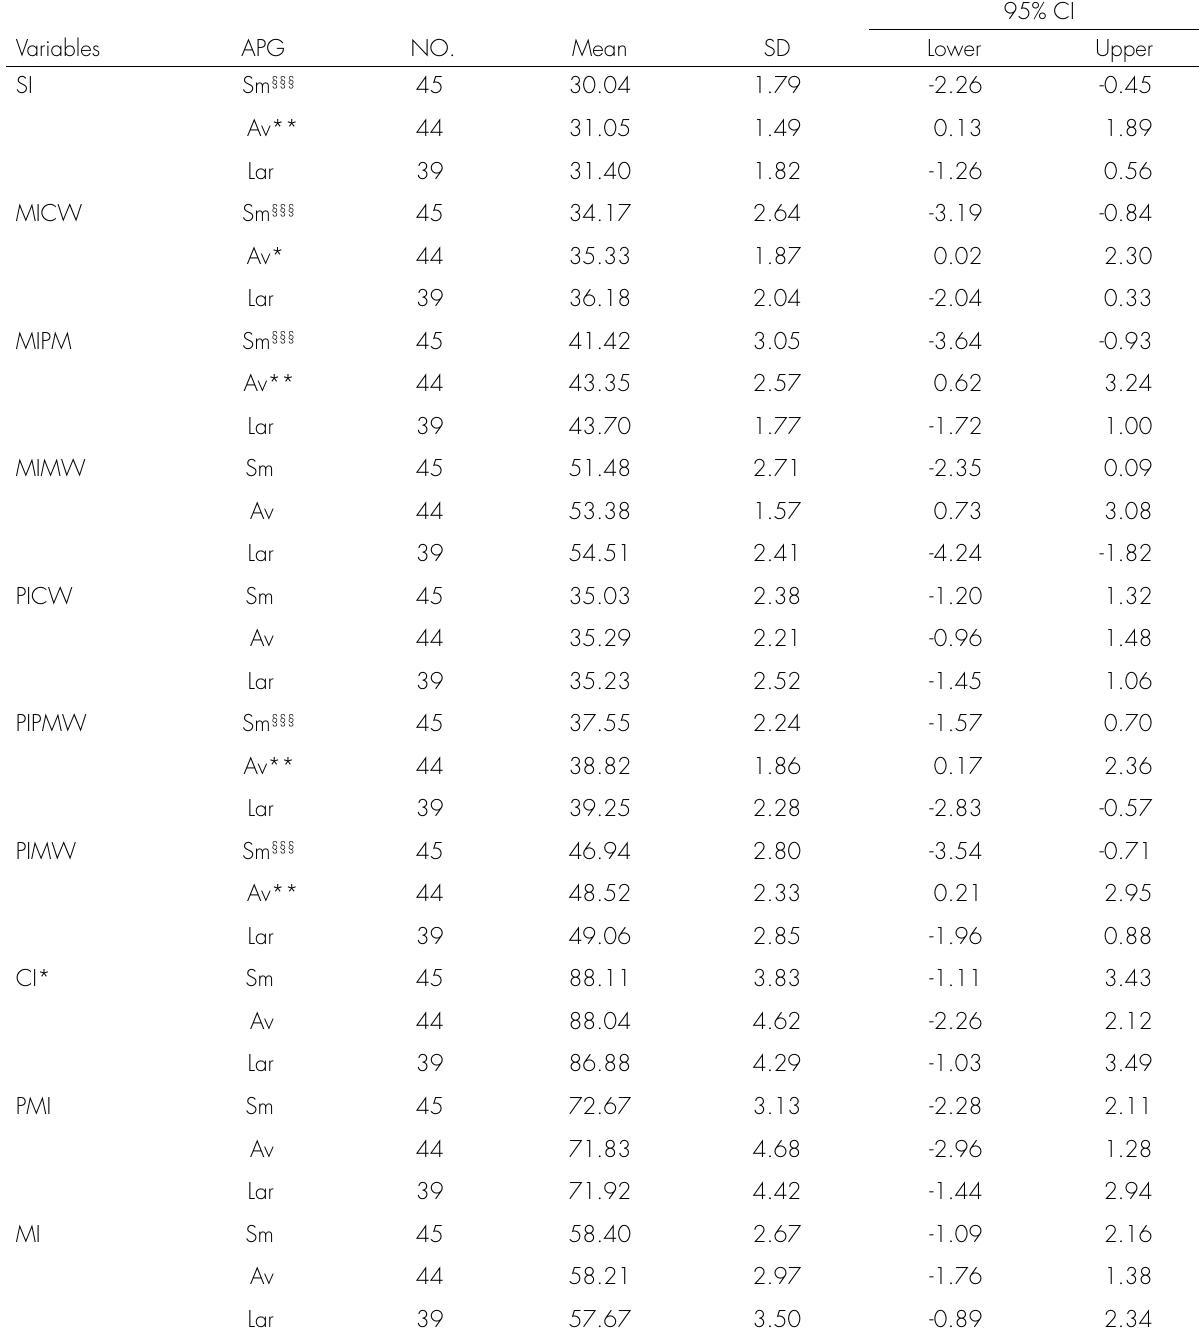
Table V. Comparison of the sum of the incisors, arch width and expansion indices in relation to various arch perimeter groups (APG) of the maxillary